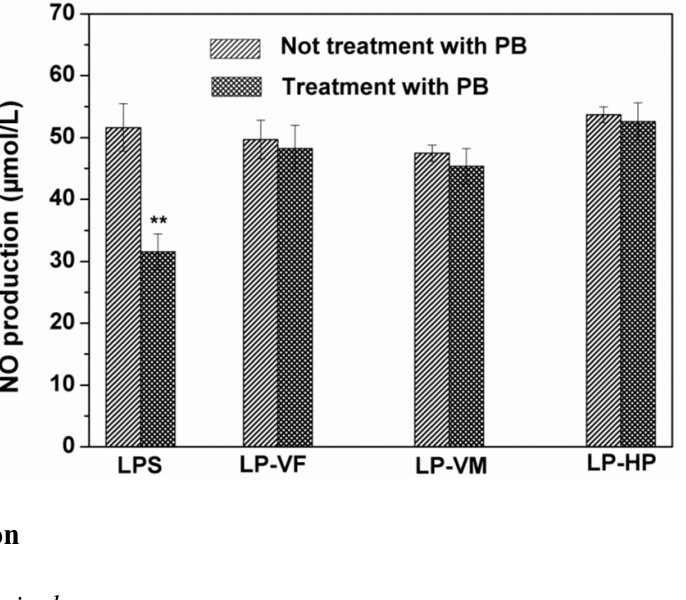
Figure 5. Effects of polymyxin B on the biological activity of litchi polysaccharide-protein complexes. LPCs (200 μg/mL) and LPS (5 μg/mL) with or without PB ( 10 μg/mL ) were added to stimulate RAW264.7 macrophages. NO were measured by ELISA kits. The results were expressed as the mean ± standard deviation ( n = 6). ** p < 0.01 compared with LPS treatment without PB. LP-VF: Litchi polysaccharide-protein complexes from vacuum freeze dried pulp; LP-VM: Litchi polysaccharide-protein complexes from vacuum microwave dried pulp; LP-HP: Litchi polysaccharide-protein complexes from heat pump dried